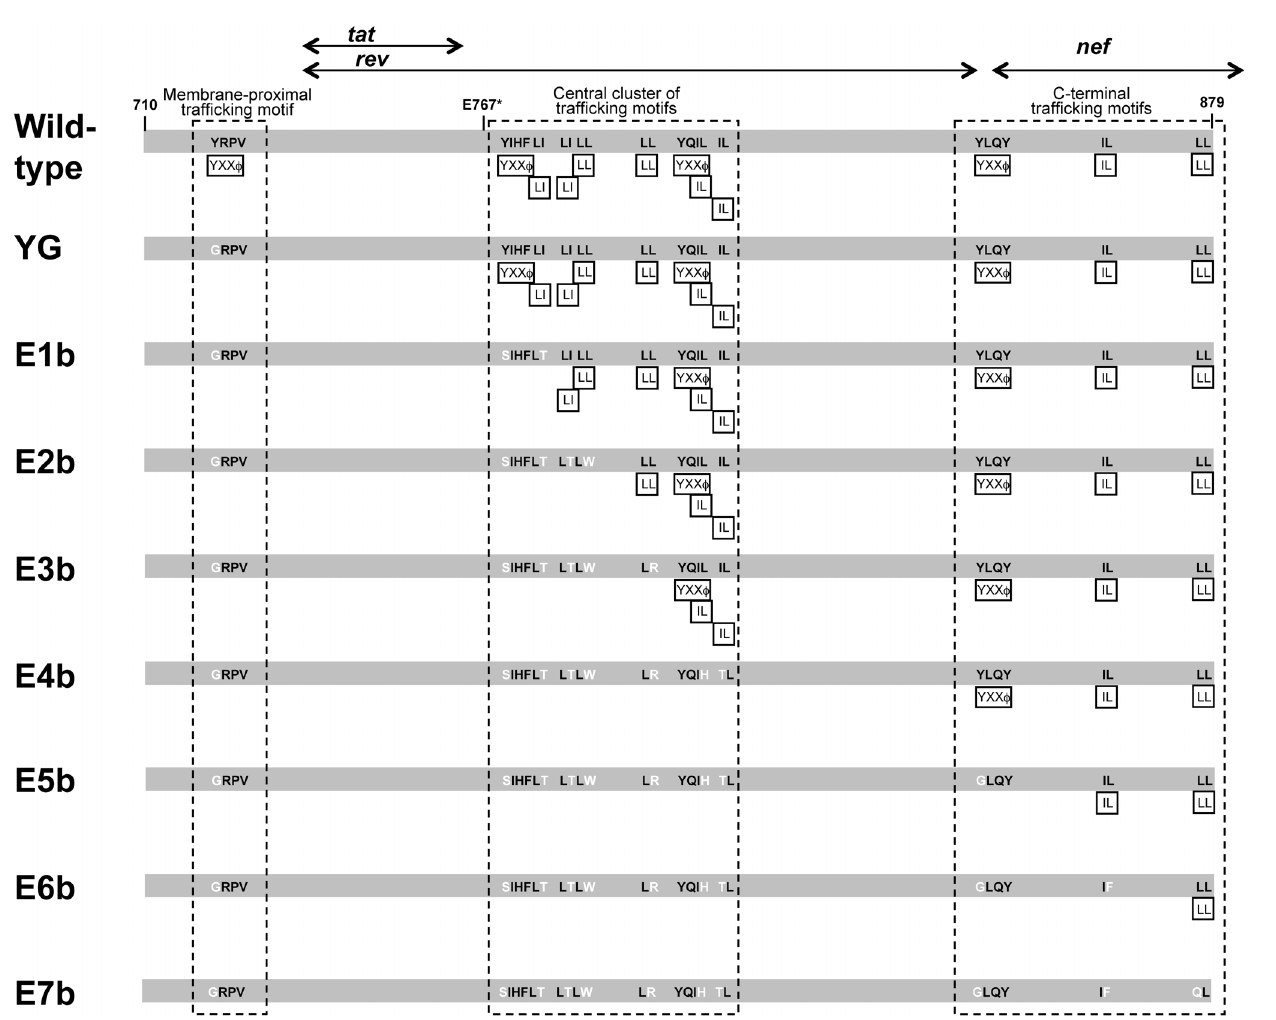
Figure 1. Schematic representation of mutations within the cytoplasmic domain of gp41. Black boxes indicate location and type of potential trafficking motifs. Black arrows represent overlapping reading frames for rev , tat , and nef , respectively. Stripes mark the membrane-proximal trafficking motif, the central cluster of trafficking motifs and the C-terminal trafficking